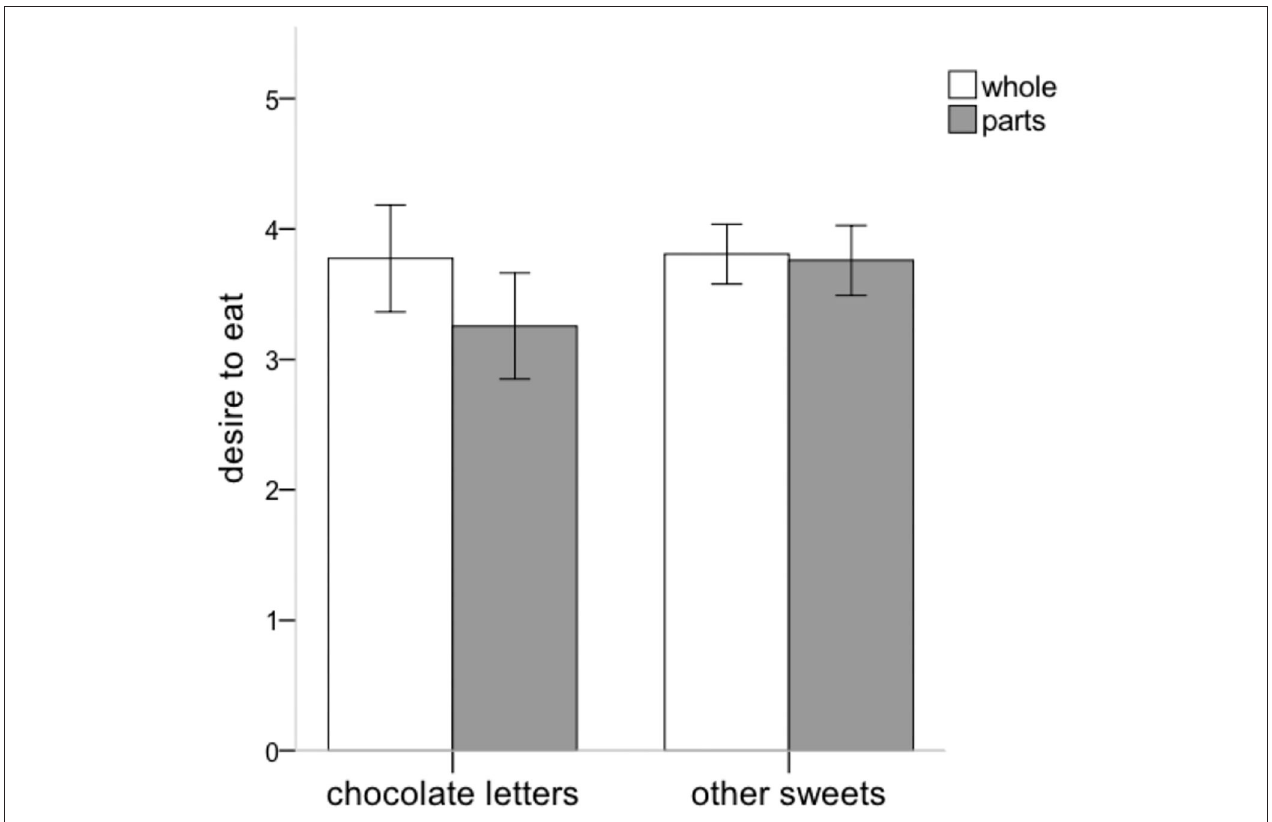
FIGURE 2 | Graph of the focus by type of sweets interaction for desire to eat (Study 2).